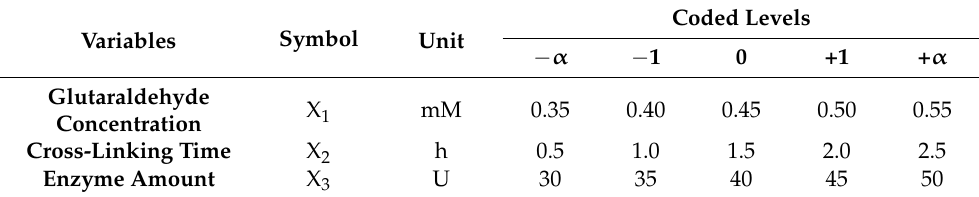
Table 3. Levels of the variables tested in the central composite